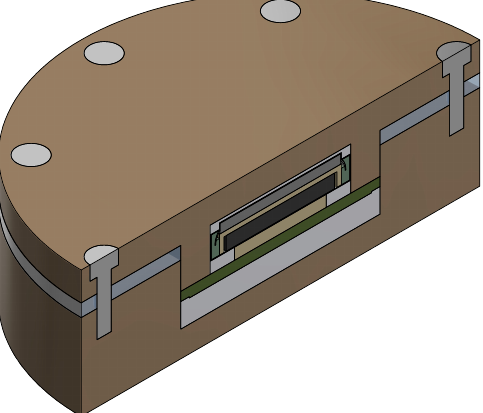
Figure 4. Simplified 3D model used for